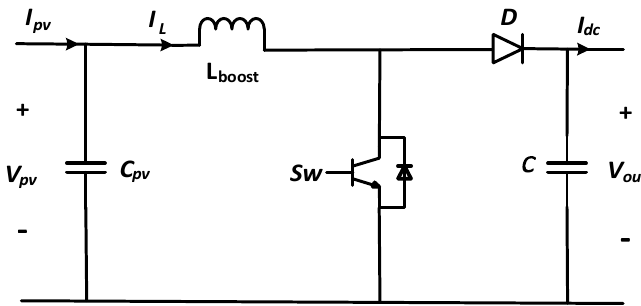
Figure 2. Equivalent circuit of the boost converter.